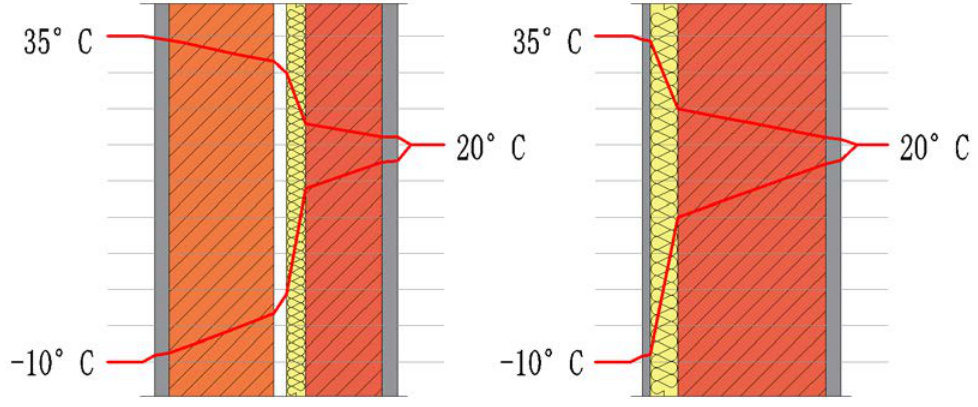
Figure 3. Temperature variation in exterior walls (author’s archives based on [8]).